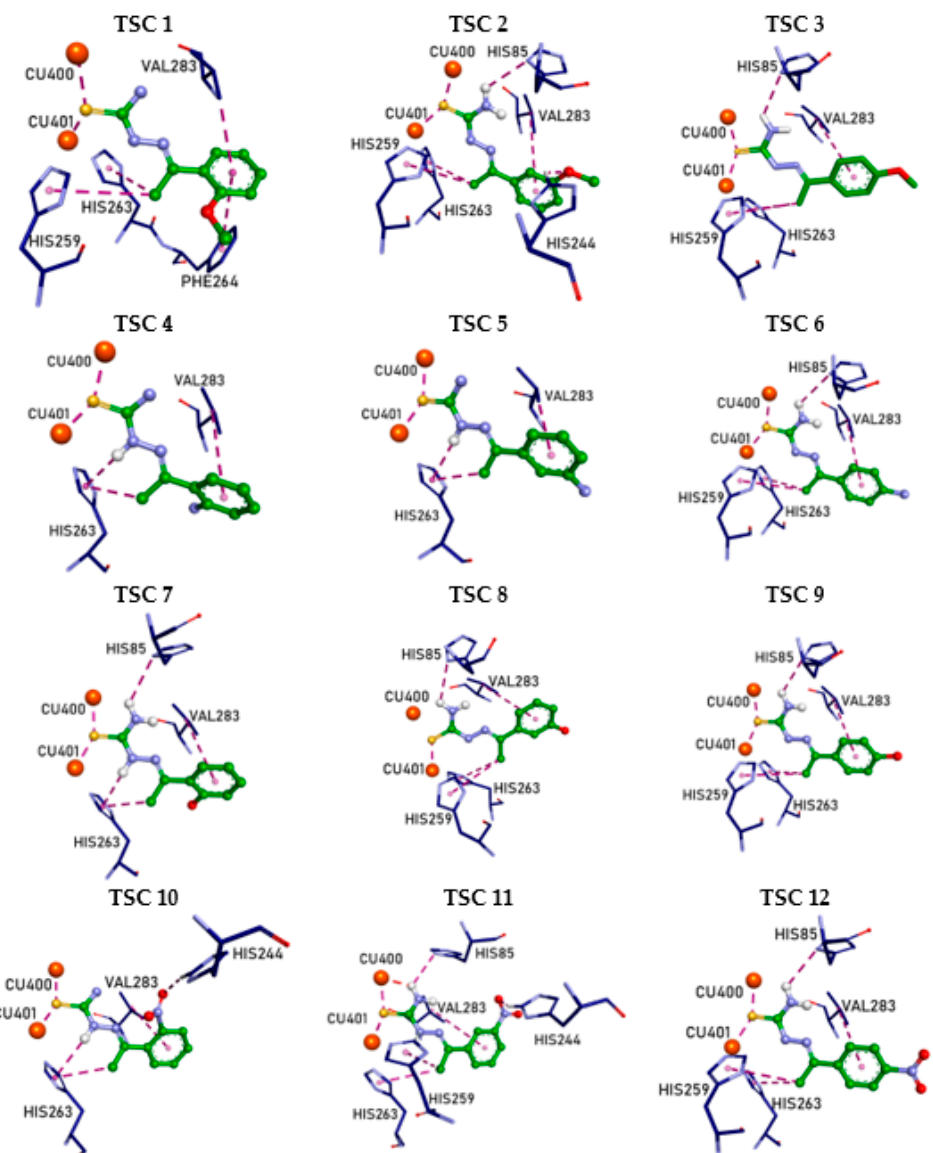
Figure 6. Interactions of TSCs 1–12 in the active site of tyrosinase visualized in BIOVIA Discovery StudioVisualizer [34]. Copper ions are represented as orange spheres; amino-acid residues are represented as sticks; inhibitors are represented by balls and sticks (green—carbon of TSCs; dark blue—carbon of amino acids, yellow—sulfur; light blue—nitrogen; red—oxygen; hydrogens are not presented if they did not participate in the interactions; purple lines—interactions).